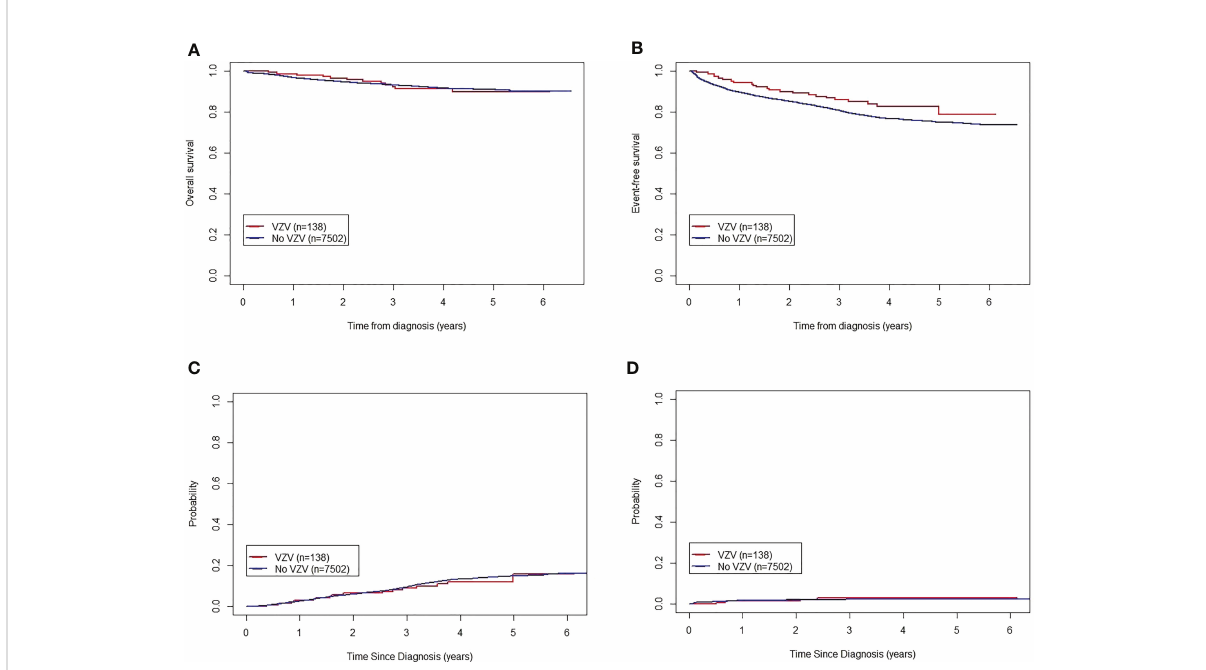
FIGURE 1 In fl uence of varicella zoster virus infection on the outcomes of children with acute lymphoblastic leukemia treated according to the CCLG-ALL- 2015 protocol. (A) Five-year OS of patients with and without VZV infection. (B) Five-year EFS of patients with and without VZV infection. (C) Five-year CRR of patients with and without VZV infection. (D) Five-year death in remission of patients with and without VZV infection. CCCG- ALL-2015, Chinese Children ’ s Cancer Group-Acute Lymphoblastic Leukemia-2015 trial; CRR, cumulative recurrence rate; EFS, event-free survival; OS, overall survival; VZV, varicella-zoster